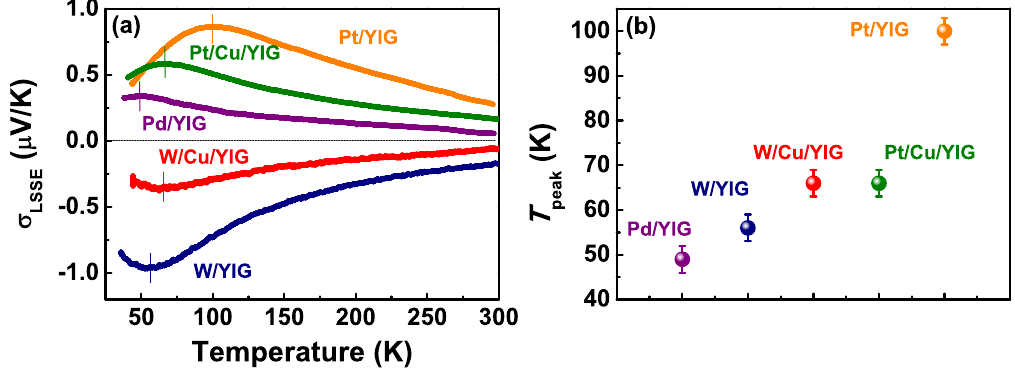
FIG. 4. (a) Temperature-dependent σ measured at Pt/YIG, Pd/YIG, W/YIG, Pt/Cu/YIG, and W/Cu/YIG hybrids. The thickness of LSSE YIG films is 50 μ m. (b) The peak positions of the σ - T curves measured for YIG films with different capping LSSE